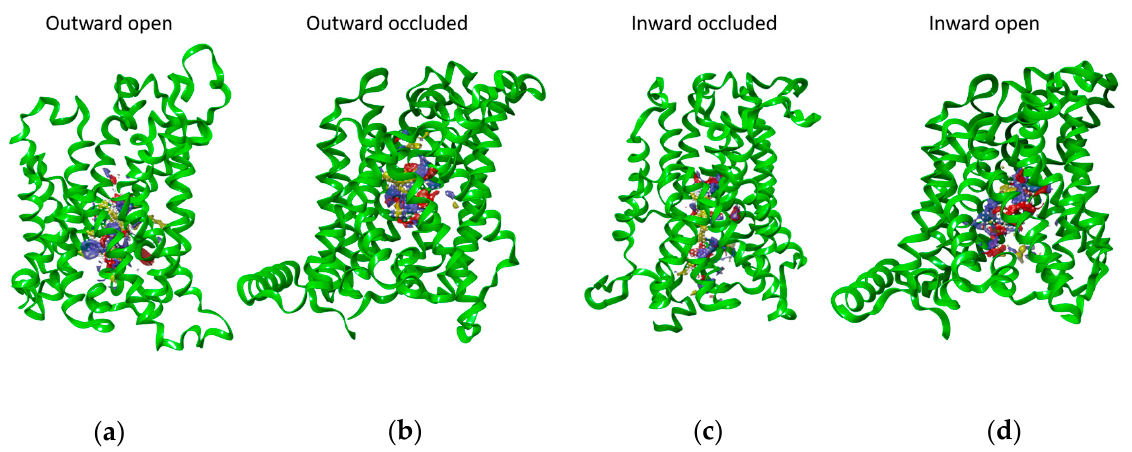
Figure 3. Binding site prediction through SiteMap. The sub-regions of LAT1 in the outward open ( a ), outward-occluded ( b ), inward-occluded ( c ), and inward-open conformation ( d ) that can form bonds or interactions with possible substrates are highlighted using the following color code: Hydrophobic map—yellow mesh, hydrogen-bond donor map—blue mesh, hydrogen-bond acceptor map—red mesh.